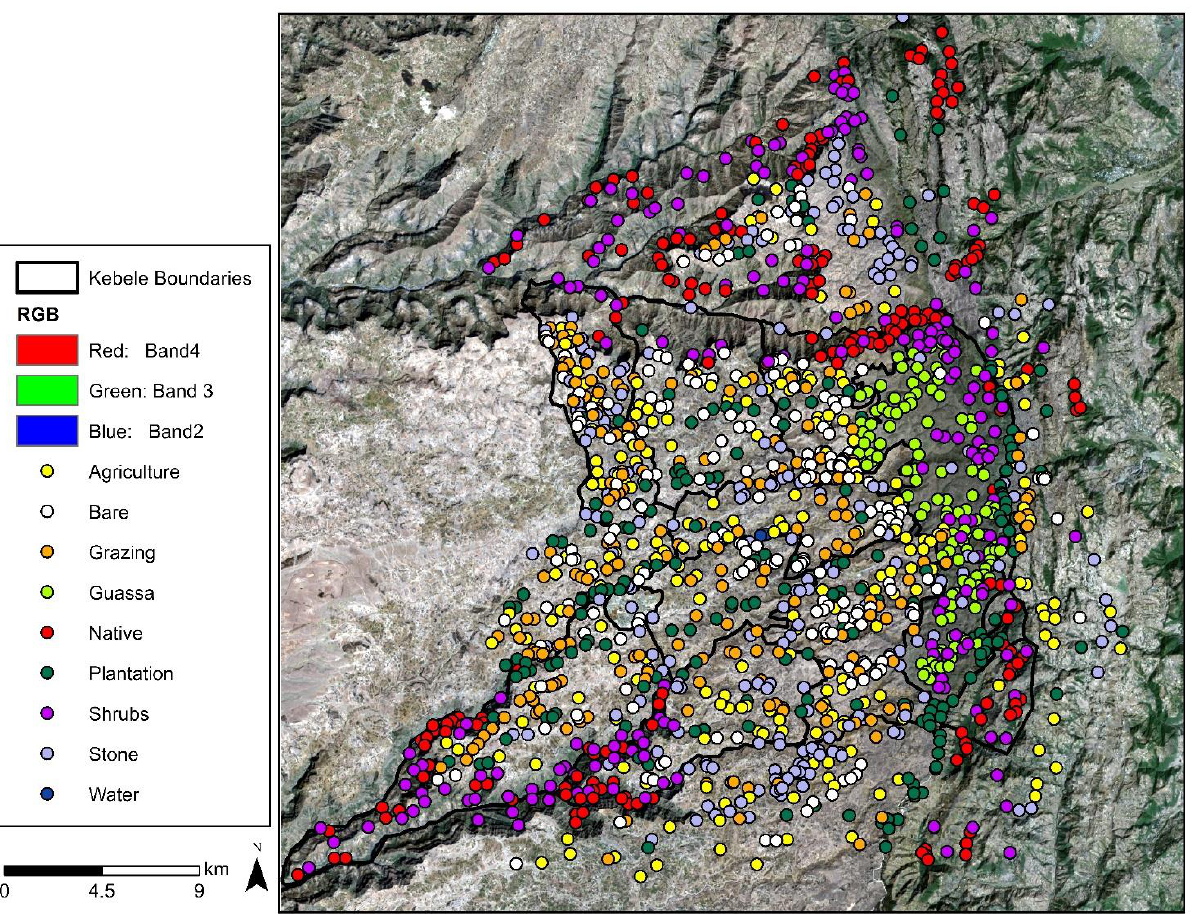
Fig. A1.2. Map displaying the distribution of training points used for each land class in the random forest